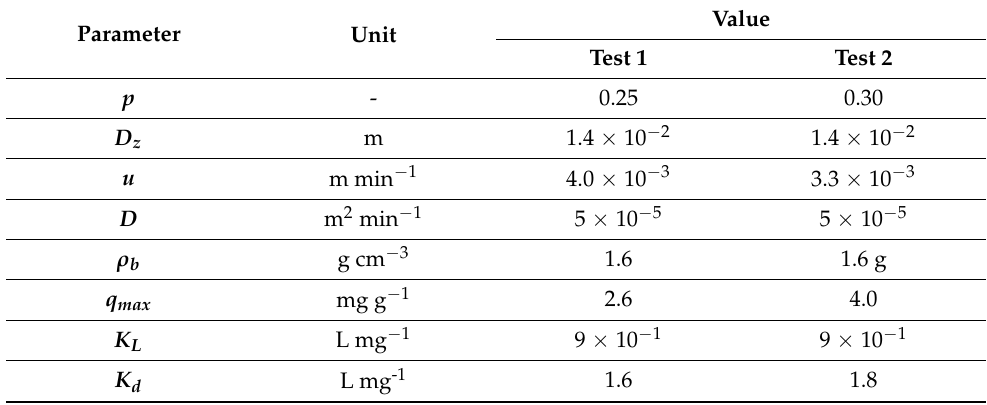
Figure 4. Comparison between the experimental data and the numerical ones obtained using Langmuir isotherm for Test 1 ( a ) and Test 2 ( b ). The experimental and simulated data were normalized by the respective highest concentration value for both columns. Table 3. Values of the parameters used for the simulation of the two column